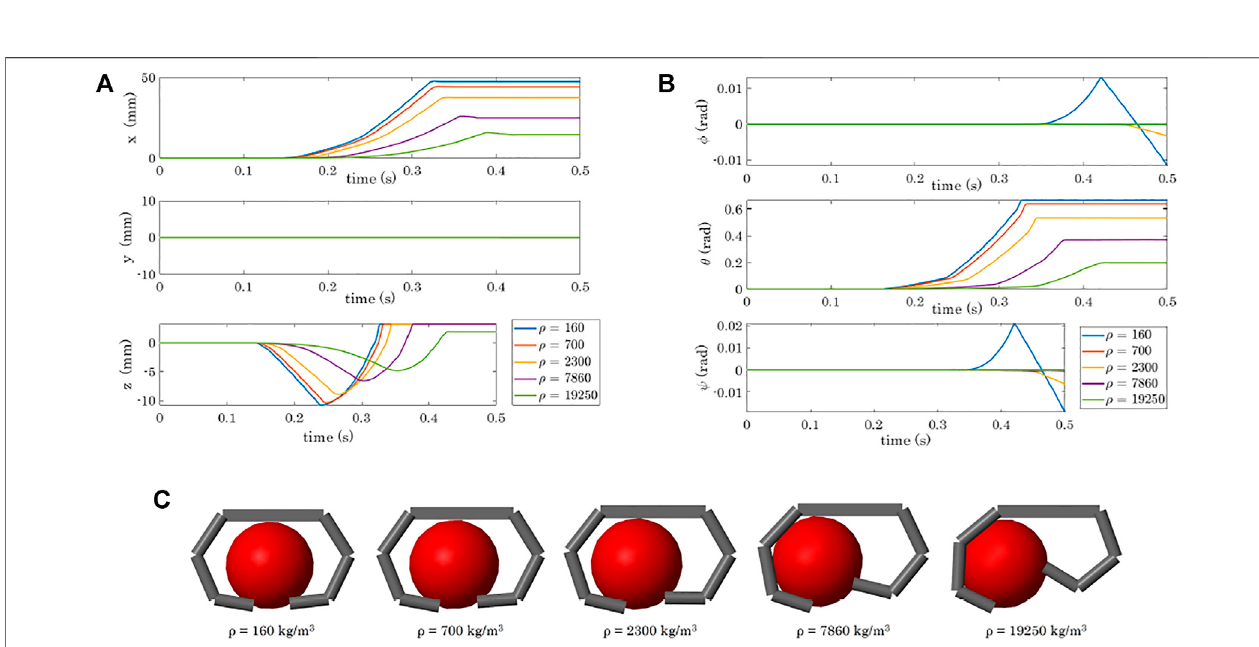
FIGURE 12 | Variation of the object pose depending on the object density: position (A) and orientation (B) . (C) Obtained fi nal grasps in the 5 simulations.